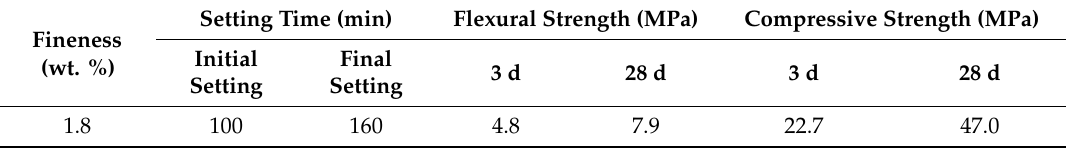
Table 1. Physical and mechanical properties of ordinary Portland cement (OPC).